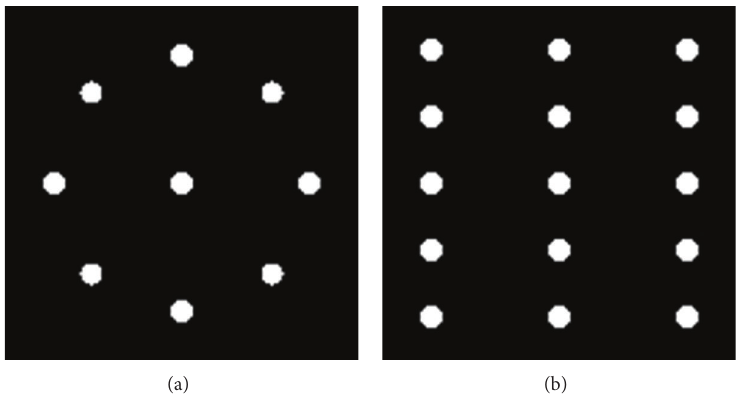
Figure 2: Transverse (a) and coronal (b) views of the spherical